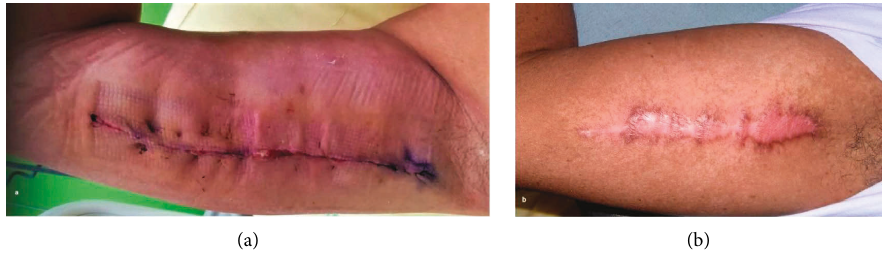
Figure 5: (a) Donator site immediately after the operation. (b) 6 months postoperative